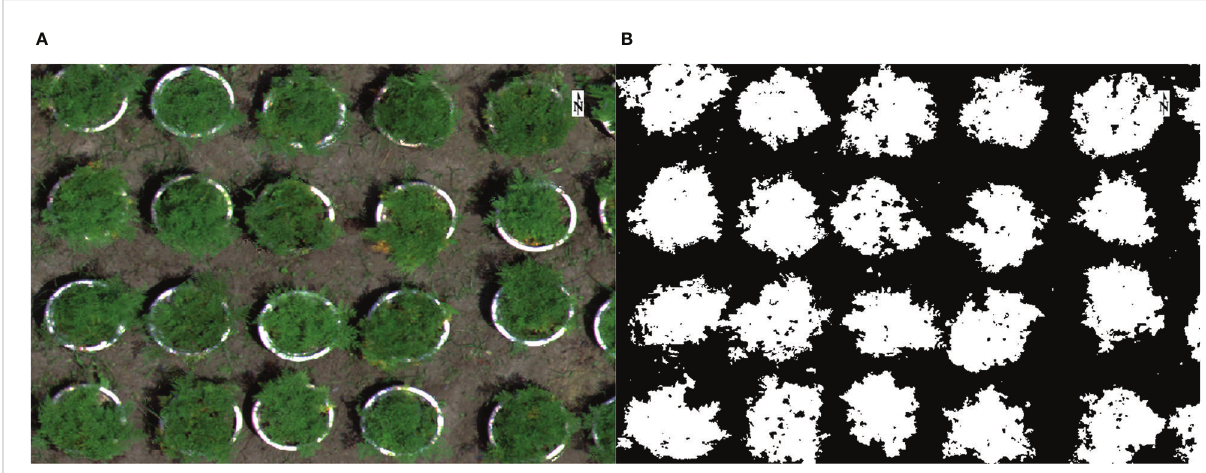
FIGURE 3 Mask extraction. Support vector machines (SVM) separated the crop crown from the background. (A) RGB image. (B)